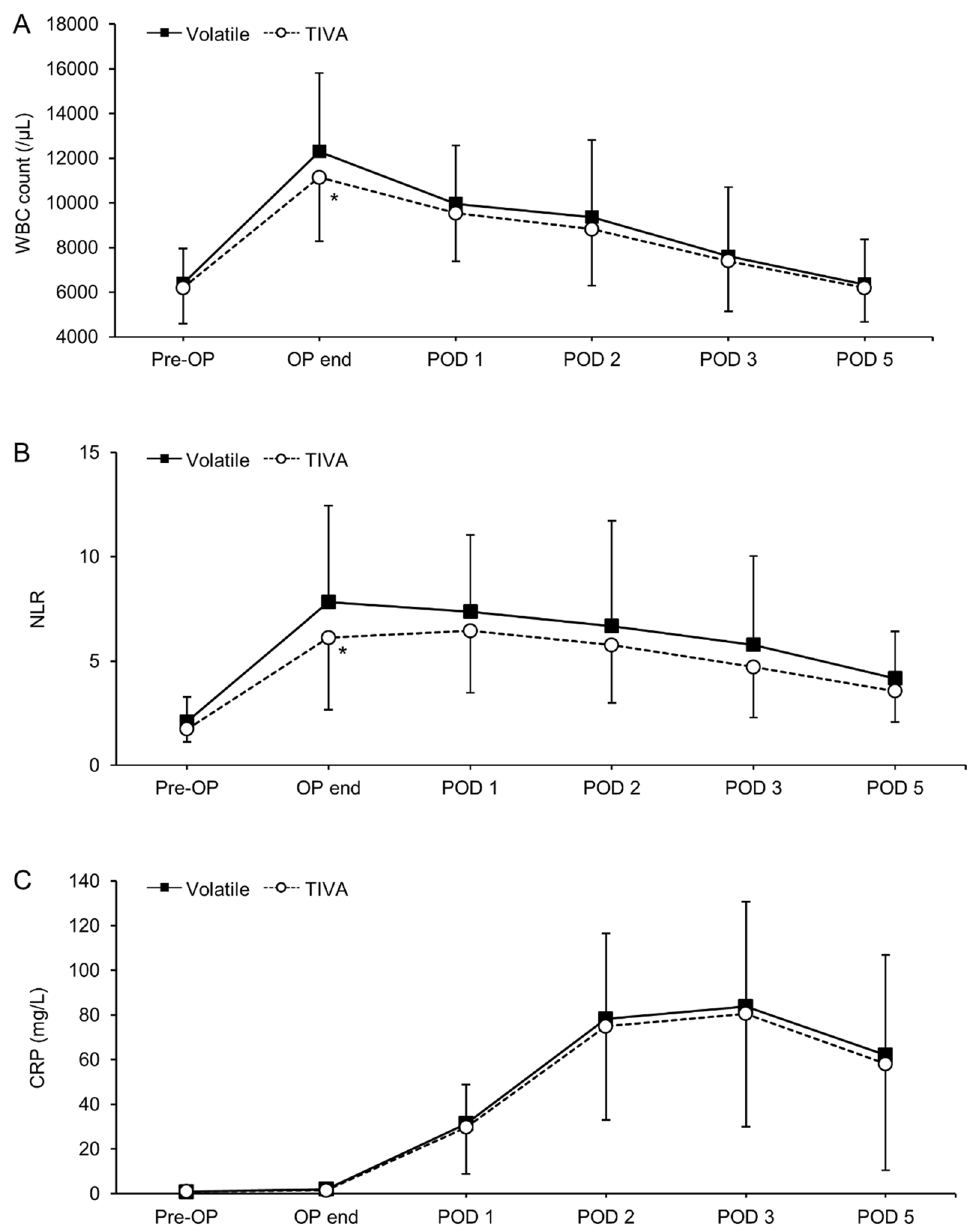
Figure 4. Perioperative changes in ( A ) white blood cell (WBC) counts, ( B ) neutrophil/lymphocyte ratio (NLR), and ( C ) C-reactive protein (CRP). OP, operation; POD, postoperative day; TIVA, total intravenous anesthesia. Values are expressed as mean ± SD. *Bonferroni-corrected P < 0.05 versus Volatile